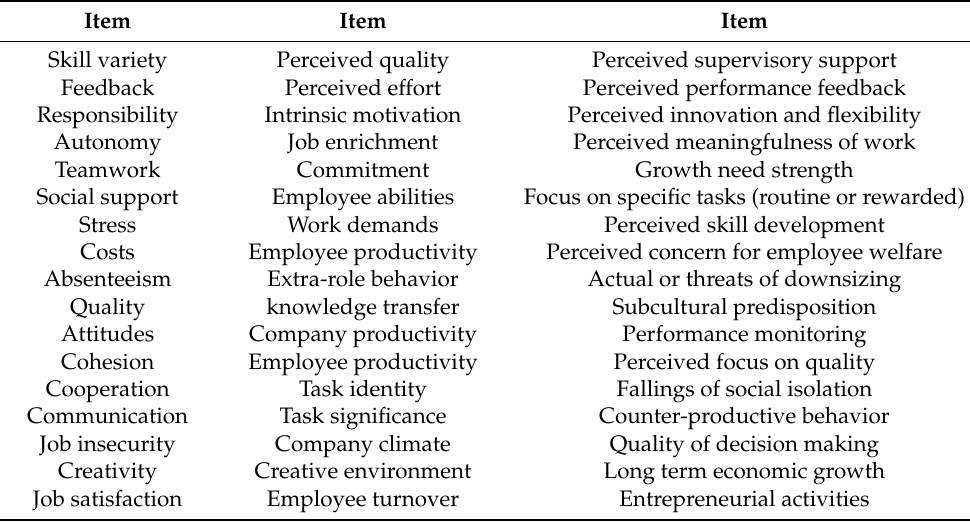
Table 2. Items in on the wellbeing theme.